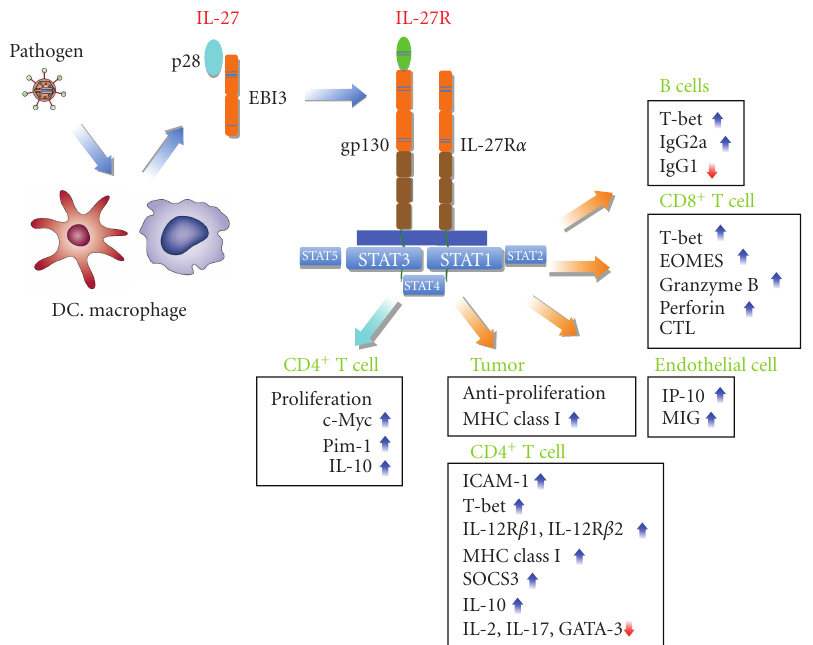
Figure 2: IL-27 is a multifunctional cytokine that mainly activates both STAT1 and STAT3 together with STAT2, STAT4, and STAT5. IL-27 mediates its several biological functions by selectively utilizing these STAT1 and STAT3, which bind to distinct IL-27R subunits, IL-27R α and gp130, respectively. IL-27 acts on various types of cells including CD4 + and CD8 + T cells, B cells, NK cells, macrophages, mast cells, and endothelial